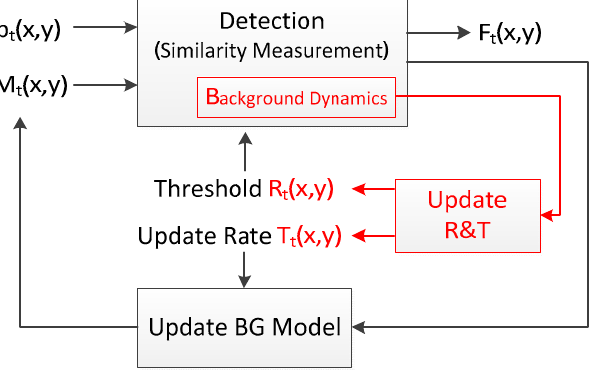
Figure 5. Feedback loop used in PBAS.